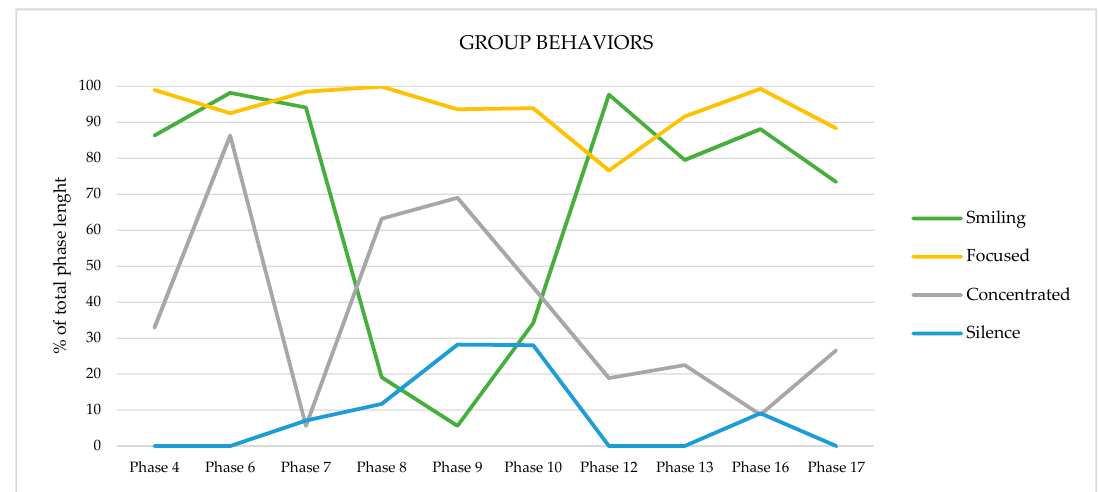
Figure 5. The figure shows the trend of the overall group’s behaviours.